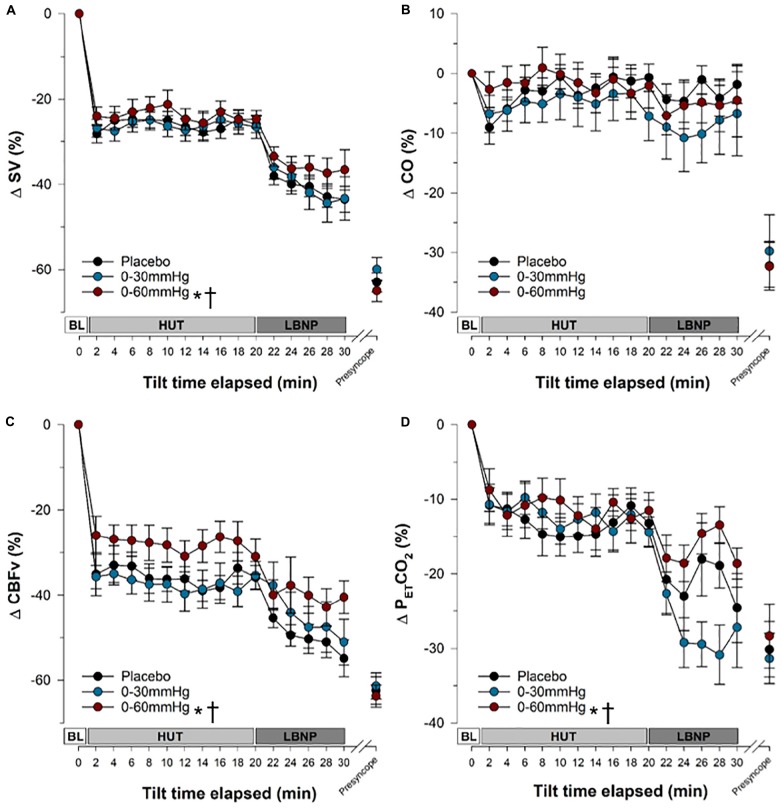
Stroke volume, cardiac output, cerebral blood flow velocity and end-tidal CO2 responses during tilt testing. The time course of stroke volume (A), cardiac output (B), cerebral blood flow velocity (C) and end-tidal carbon dioxide (D) during tilt are shown. Symbols (mean ± SEM) reflect averaged data, over the last 30 s of every 2 min interval and are reported as a percentage change from supine values. Main effects of condition throughout tilt are shown. ∗Significantly different from placebo (p < 0.001); †significantly different from 0 to 30 mmHg compression. SV, stroke volume; CO, cardiac output; CBFv, cerebral blood flow velocity; PETCO2, end tidal partial pressure of carbon dioxide; BL, baseline; HUT, head-upright tilt; LBNP, lower body negative pressure.